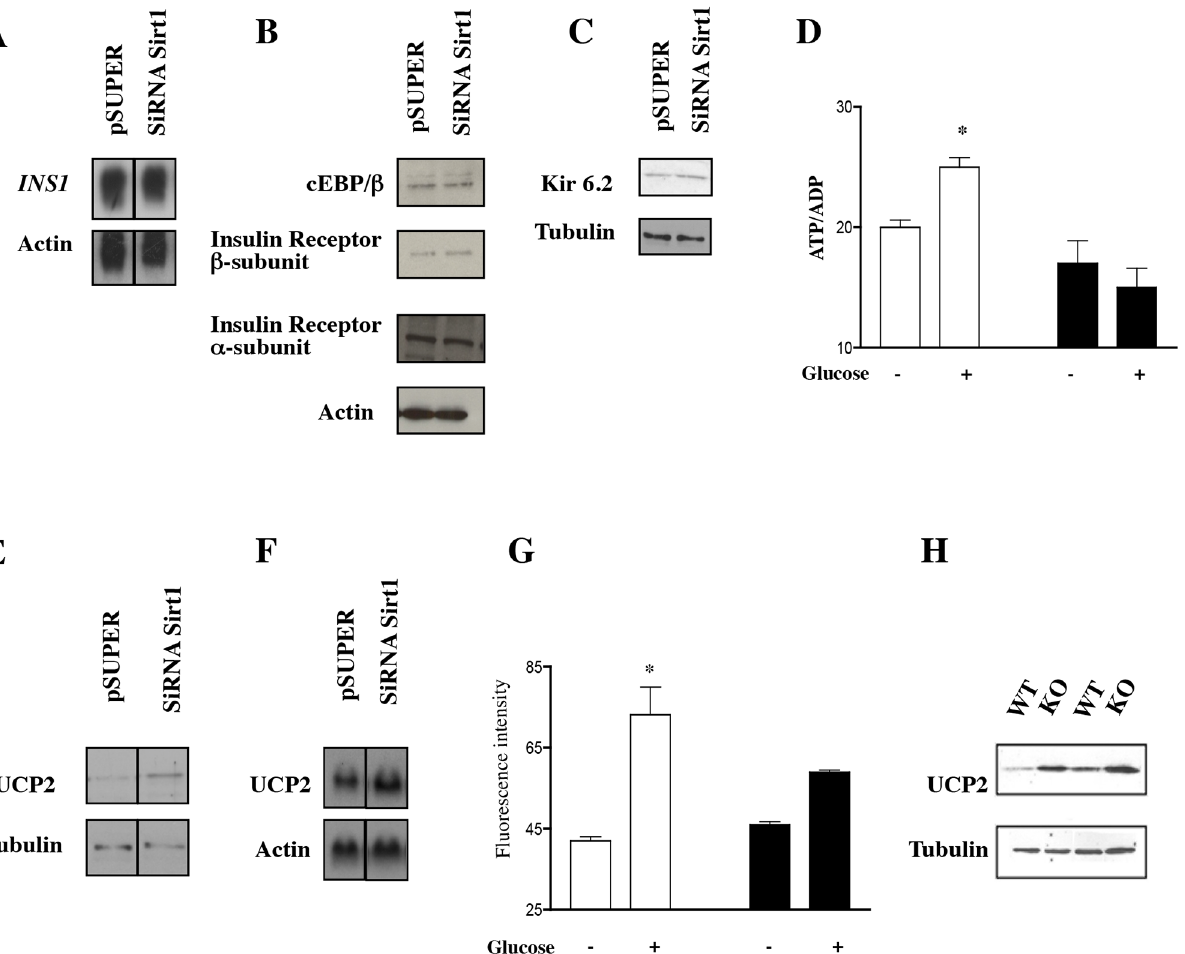
Fig 4. UCP2 is Up-Regulated in Sirt1 Knockdown Cells and in Sirt1 KO Mice. (A) Northern blot for the insulin gene INS-1 in cells with a control vector (pSUPER) or a SiRNA-Sirt1 vector (SiRNA Sirt1). Vertical lines indicate where the respective original blots were spliced together. (B and C) Western blot analyses of targets involved in insulin synthesis and secretion using specific antibodies: cEBP/ β , insulin receptor α and β , and kir6.2, one of the K + channel receptor subunits. (D) Measurement of ATP/ADP levels in INS-1 control cells (open bars) or Sirt1 knockdown cells (black bars) treated with 16.7 mM glucose (+) or 4 mM glucose ( − ) ( n = 3 experiments done in triplicate, * p < 0.005 in the pSUPER experiment; ANOVA). (E) Western blot analysis for UCP2 in INS-1 control cells (pSUPER) or knockdown cells (SiRNA Sirt1). Vertical lines indicate where the respective original blots were spliced together. (F) Northern blot analysis for UCP2 in INS-1 control cells (pSUPER) or knockdown cells (SiRNA Sirt1). Vertical lines indicate where the respective original blots were spliced together. (G) NADH levels in INS-1 cells after glucose addition as determined by autofluorescence [46] and expressed as arbitrary units. Cells stably transfected with control or Sirt1 SiRNA vectors were used ( n = 2, * p < 0.05 compared with no glucose). (H) UCP2 protein levels in isolated pancreatic islets of two wild-type or two Sirt1 KO mice. Tubulin or actin was used as loading control in all Western and Northern